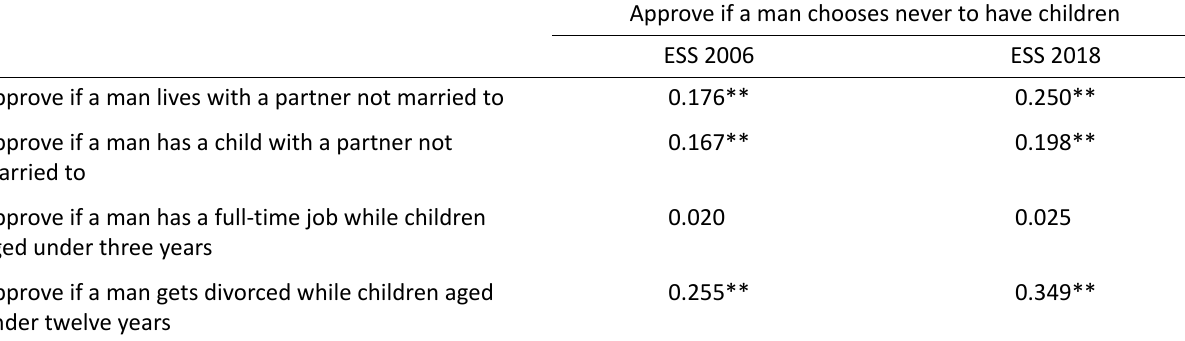
Table 3. Pearson correlations of attitudes toward male voluntary childlessness, parenthood, marriage, and divorce in